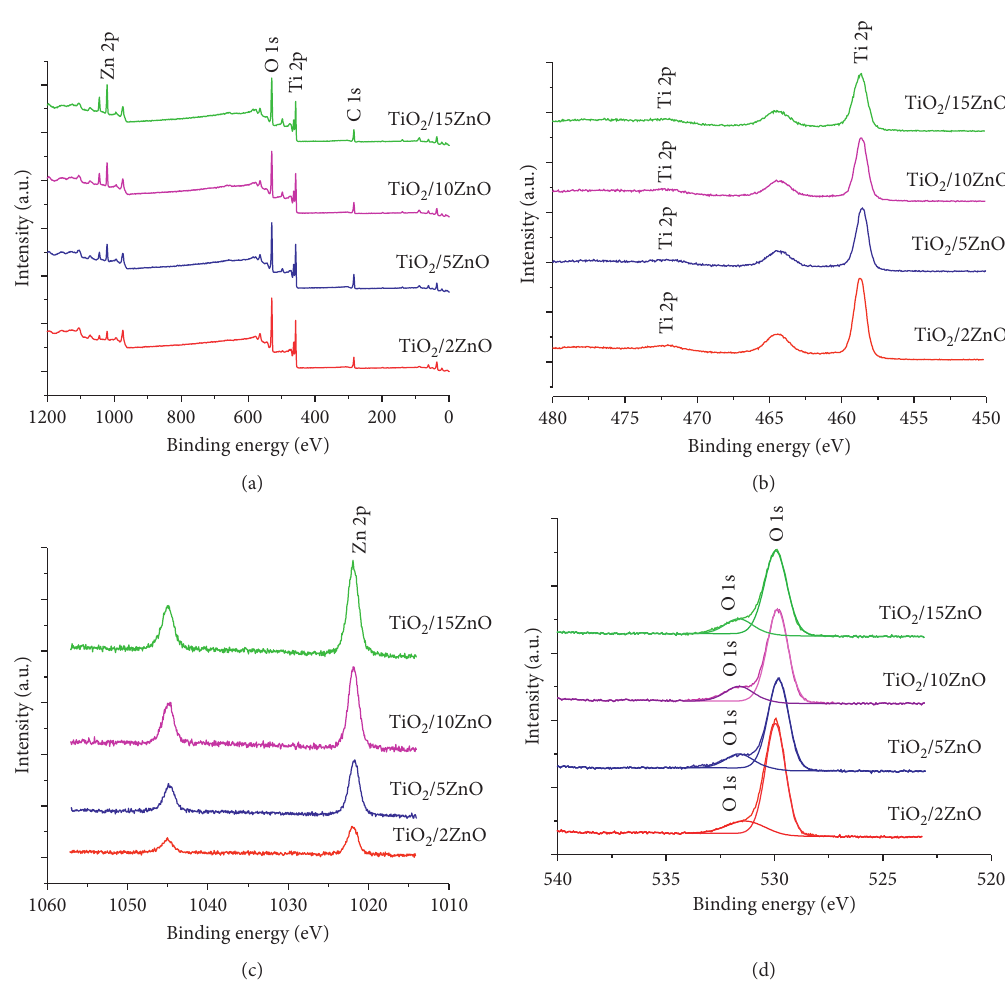
2 /P90 and TiO 2 /ZnO